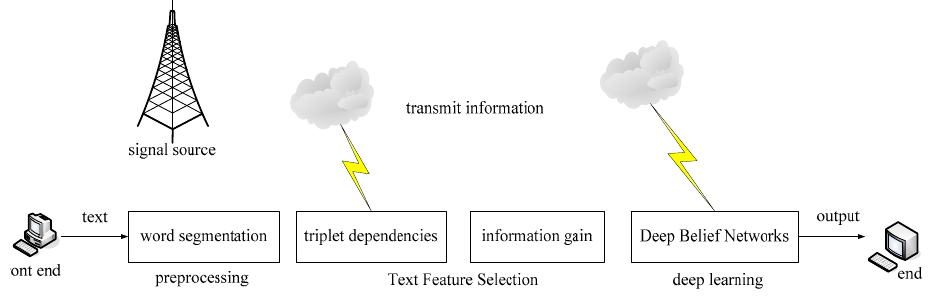
Figure 4. Flow chart of emotion classi fi cation.